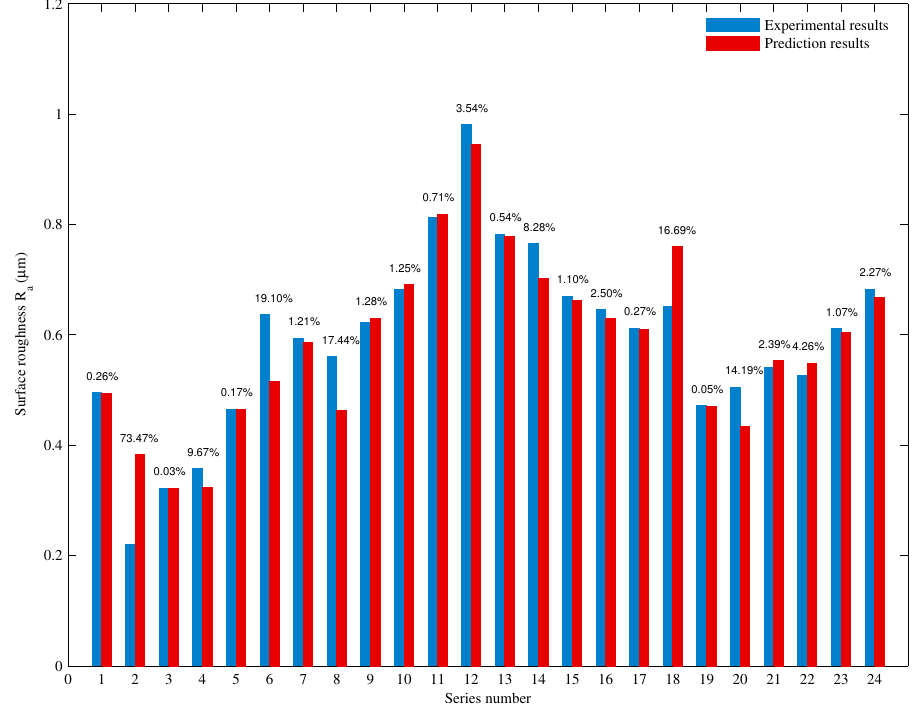
Figure 12. Comparison analysis between prediction and experimental